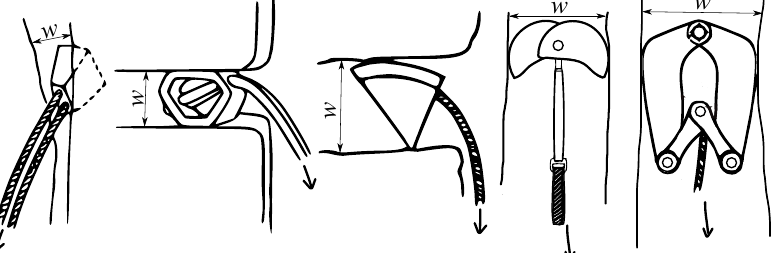
Figure 1. The passive PRG (from left): Nut, Hexentric, Tricam, and the active PRG (from right): LTMS and single-axle SLCD.